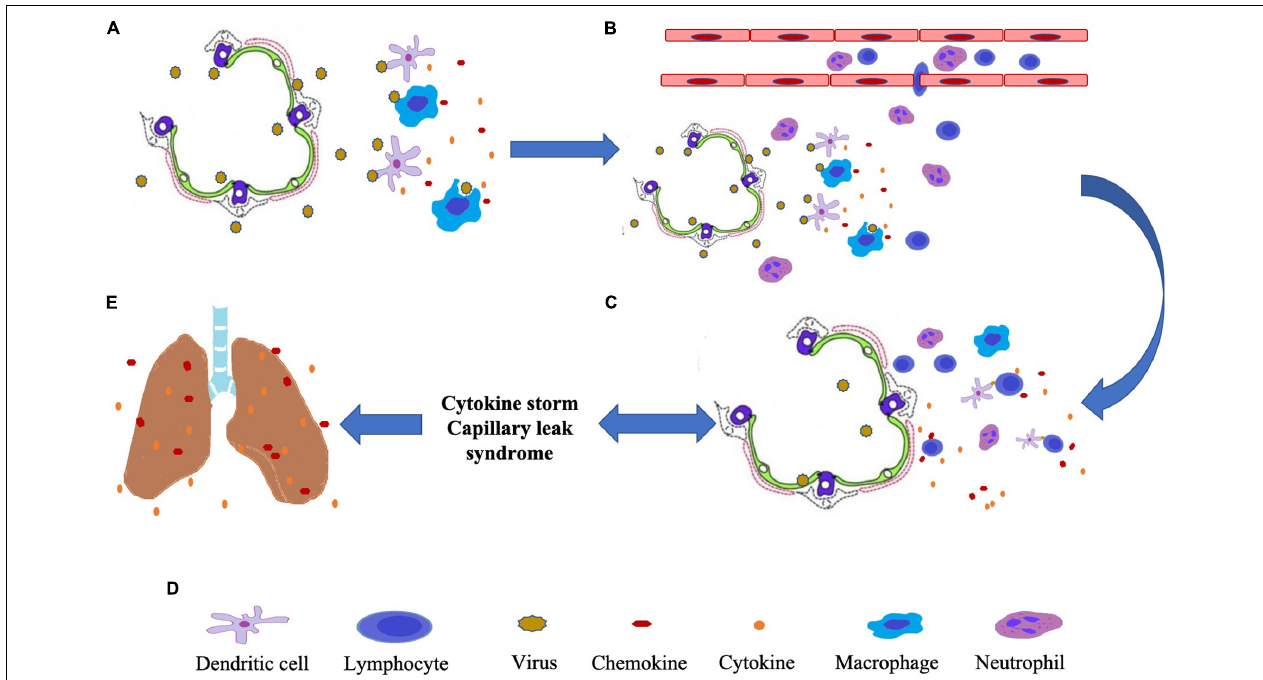
FIGURE 1 | The diagram of lung injury caused by virus-induced cytokine storms. (A) The viruses attack alveolar epithelial cells and are recognized by dendritic cells and macrophages, which then release cytokines. (B) Cytokines and chemokines help white blood cells in the blood reach the alveoli. (C) Antigen-presenting cells (dendritic cells) activate lymphocytes. Activated lymphocytes produce and release large amounts of cytokines while attacking infected alveolar epithelial cells. (D) Induce cytokine storm, and capillary leak syndrome. (E) Causes atelectasis, pulmonary edema, pulmonary congestion, and ARDS.